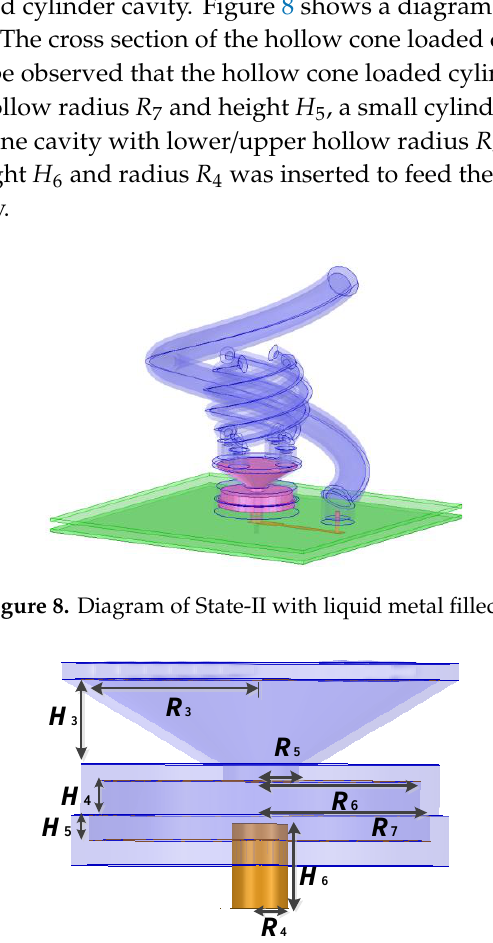
Figure 7. Simulated and measured radiation patterns for State-I: ( a ) xoz plane at 1.2 GHz; ( b ) yoz plane at 1.2 GHz; ( c ) xoz plane at 1.575 GHz; ( d ) yoz plane at 1.575 GHz.